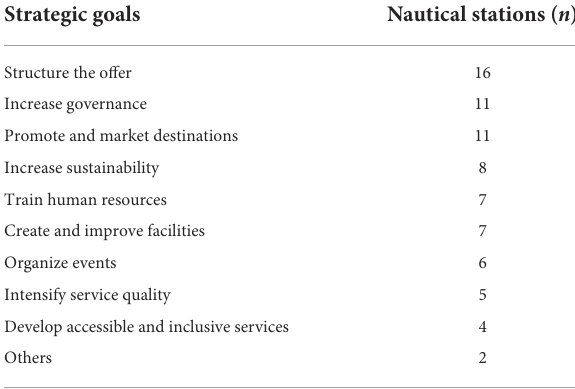
TABLE 1 Strategic goals per nautical